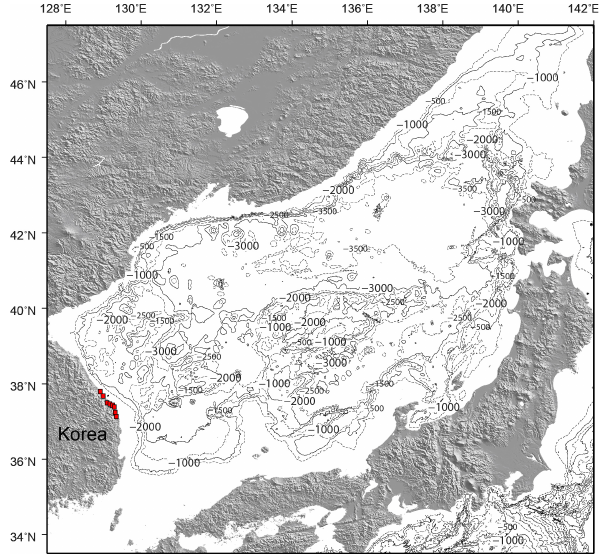
Fig. 2. Topography and bathymetry (contour unit: metre) of the East (Japan) Sea. The 8 dots along the Korean coast indicate beaches where comparisons between the observed and calculated runup heights were made (see Fig. 6).